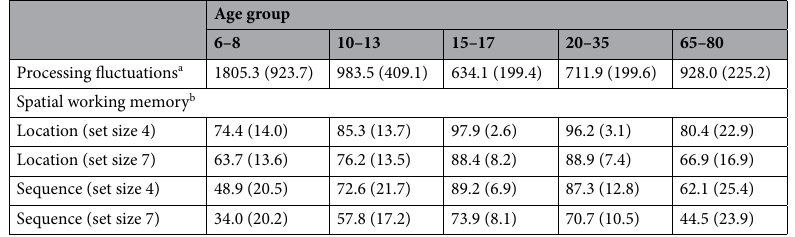
Table 2. Cognitive processing fluctuation and spatial working memory performance by memory type (location or sequence), memory load (set size 4 or 7) as well as by age group. Intraindividual cognitive processing fluctuations are computed as the trial-by-trial standard deviation of the reaction times in the Identical-Pictures task. Spatial working memory scores represent the percentage of mean accuracy with per age group. Standard deviations are provided parenthesis for all mean scores. For age group differences see text. a missing data: n = 2 in the adolescent sample and n = 1 in the older adults sample, b missing data: n = 1 in the young children sample and n = 1 in the older adult